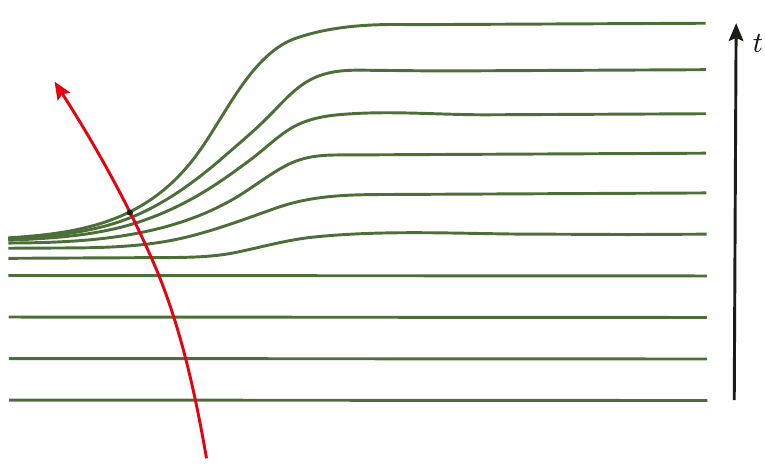
Figure 6 . The late-time saturation of the time slicing in the interior of the black hole results in a frozen momentum component, as required for any PC formula which should apply in a regime of linear complexity